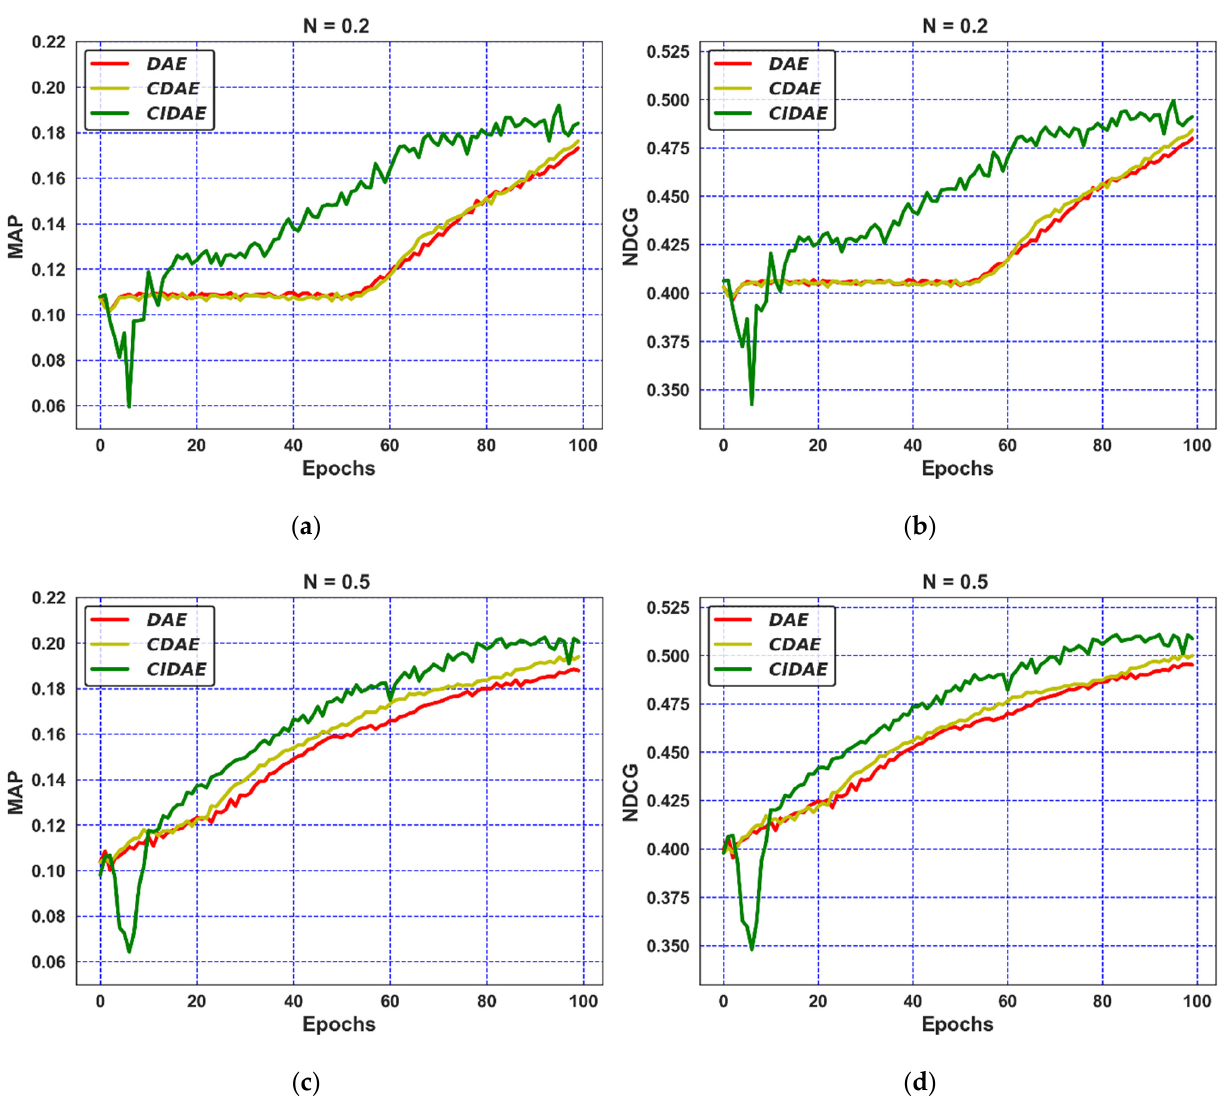
Figure 6. Performance comparison on ML ‐ 100K through MAP and NDCG metrics.